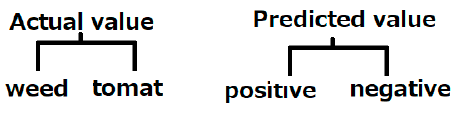
Figure 3. Illustration of information necessary to construct a confusion matrix.